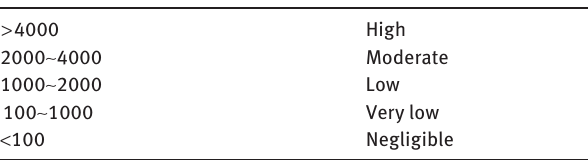
Table 3 Chloride ion penetrability based on charge passed recom- mended in ASTM C 1202